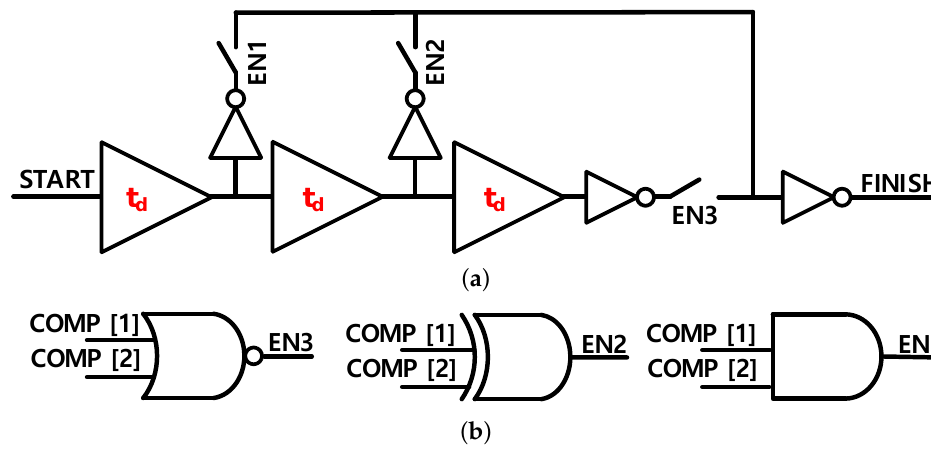
Figure 7. ( a ) Conceptual block diagram of a delay cell. ( b ) Three-step tapered control generator. Figure 8 shows the clock generator implementation that scales by integer